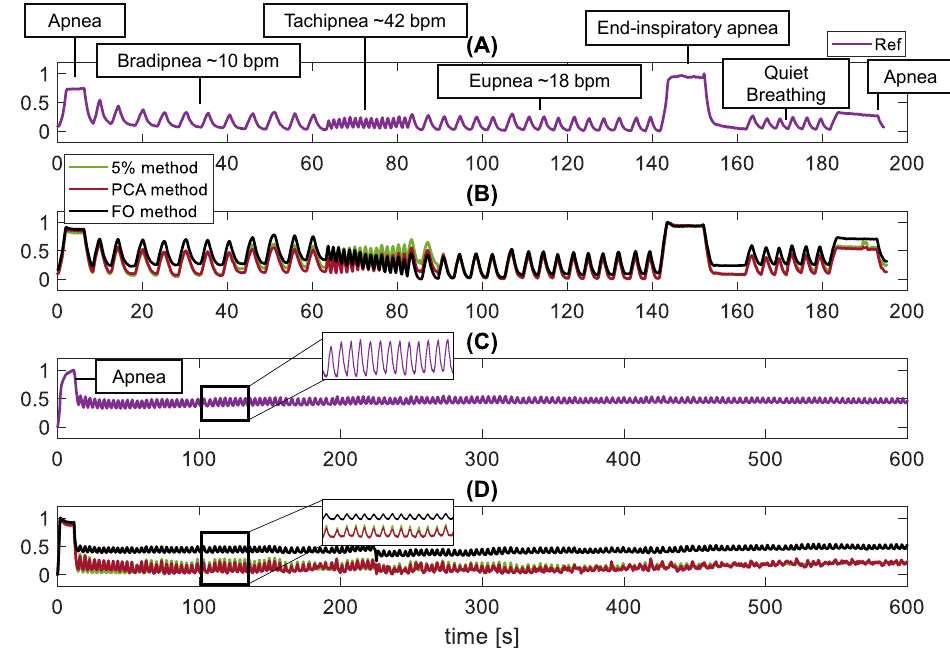
Figure 3. The 4 trends show the protocol that volunteers were asked to follow. In ( A , B ) the protocol consists of apnea for ∼ 5 s, one minute of bradypnea ( f R ∼ 10 bpm), 20 s of tachypnea ( f R ∼ 42 bpm), one minute of eupnea ( f R ∼ 12 bpm), ∼ 10 s of end-inspiratory apnea, ∼ 10 s of end-expiratory apnea, quiet breathing for ∼ 10 s and a final apnea. Whereas trends ( C , D ) show the protocol that volunteers were asked to follow in the 1.5-sup trial that includes an initial apnea of approximately 5 s and quiet breathing for approximately 600 s. In detail: ( A ) Breathing pattern recorded by the BH3 during a seated trial (0.5-Sit). The different respiratory stages are briefly indicated. ( B ) The same breathing pattern extracted from the three methods based on video processing. ( C ) Example of a breathing pattern recorded by the BH3 during a supine trial (1.5-Sup). ( D ) The same breathing pattern extracted from the three methods based on video